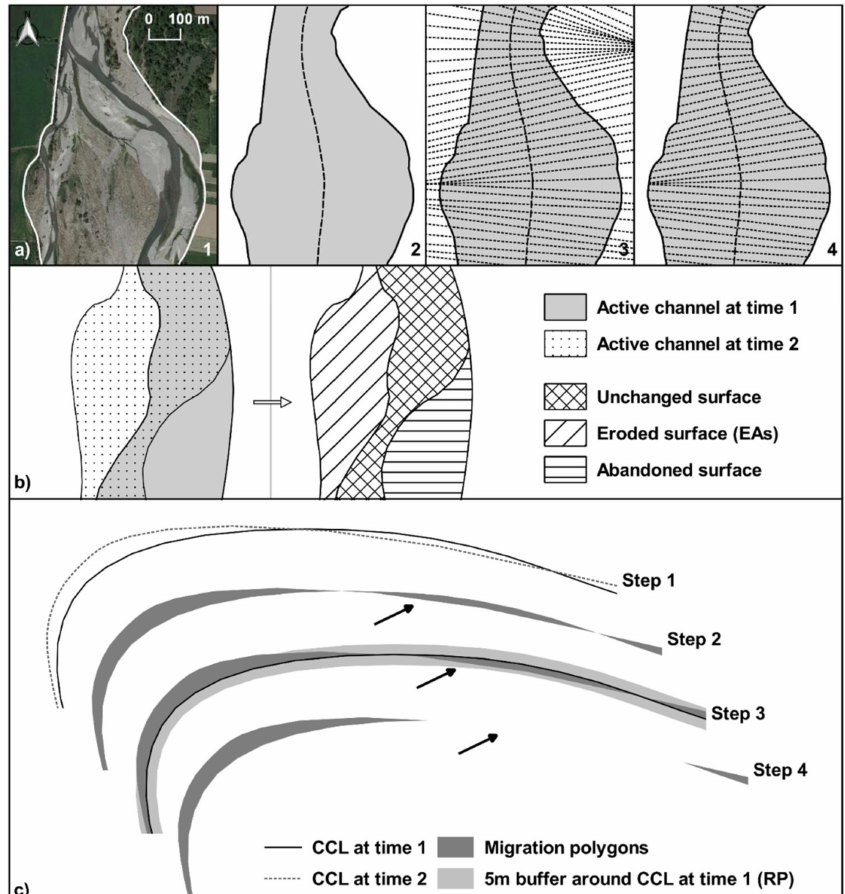
Figure 3. ( a ) Active channel definition and consecutive steps to evaluate channel width at site scale; see the text for explanation; ( b ) Polygons for the computation of NCA, PUS, PES and PDS. The superimposition of two active channel polygons resulted into three distinct layers representing (i) the areas belonging to the active channel at both times (i.e., unchanged surface); (ii) the areas converted from floodplain to active channel (i.e., eroded surface–EAs); (iii) the areas converted from active channel to floodplain (i.e., abandoned surface); ( c ) Procedure adopted in defining migration polygons; the arrow indicates a migration polygon included within the RP and thus not considered for the computation of MR; see the text for